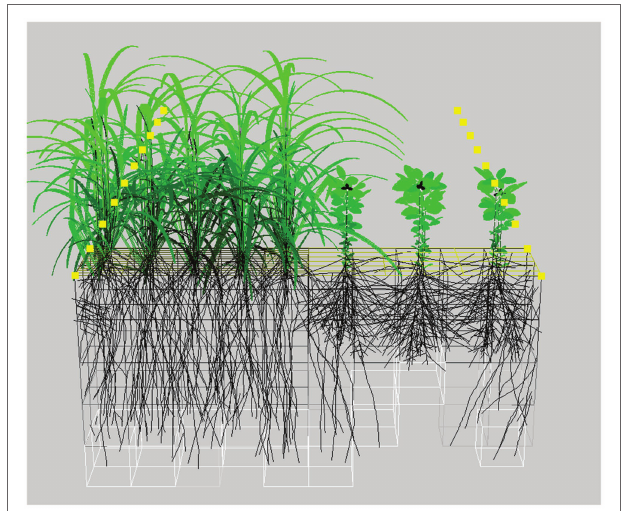
FIGURE 2 | Example of an FSP simulation of a relay cereal-legume system at 52 days after sowing. The brightness of the leaves corresponds to the leaf light capture. The boxes surrounding the roots represent the soil explored by the roots. Image created using the GroIMP modeling platform (Hemmerling et al.,